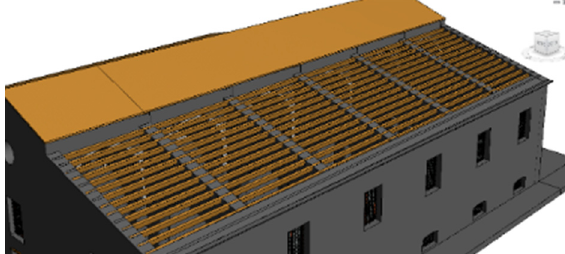
Figure 13 . The parametric model of the coverage of the “ Real Cantina Borbonica